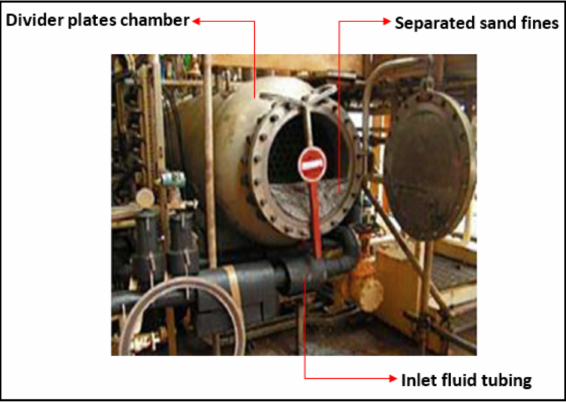
Figure 1. Illustration of separated sand fines from the produced hydrocarbon within a two-phase horizontal separator. Extracted and modified after